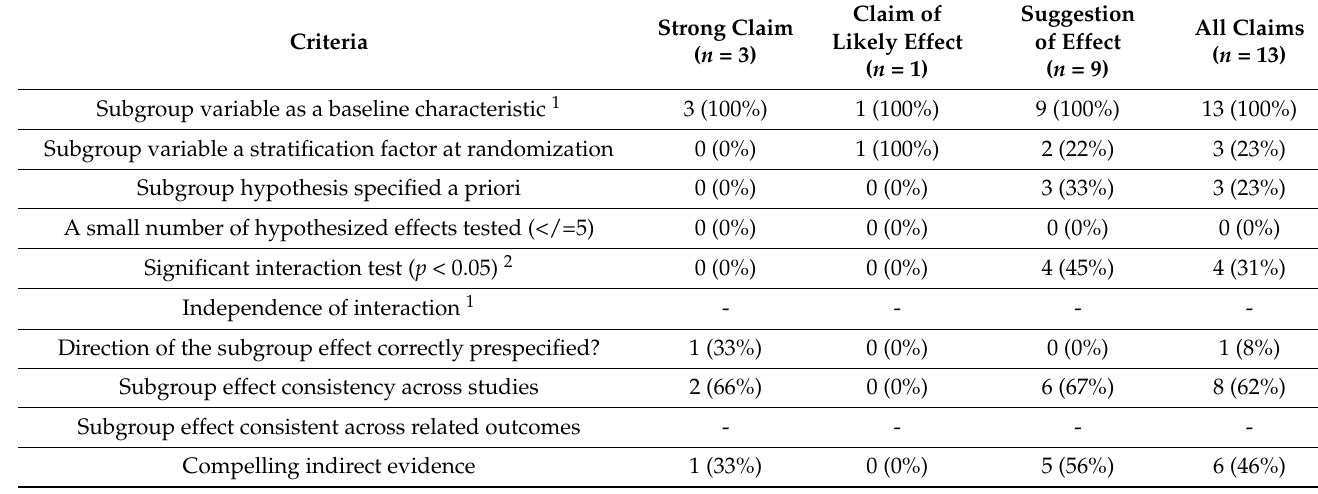
Table 4. Claims meeting Sun’s et al. subgroup criteria for primary